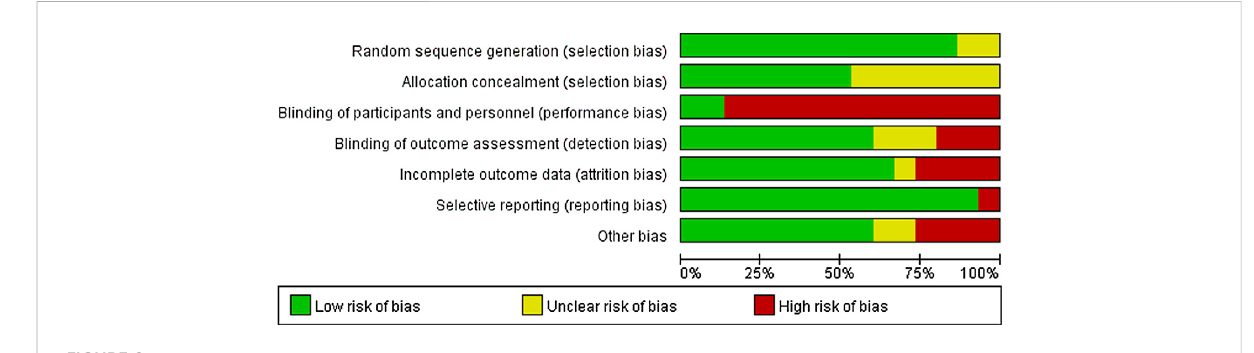
FIGURE 2 Combined percentage risk of bias in each risk domain for all included